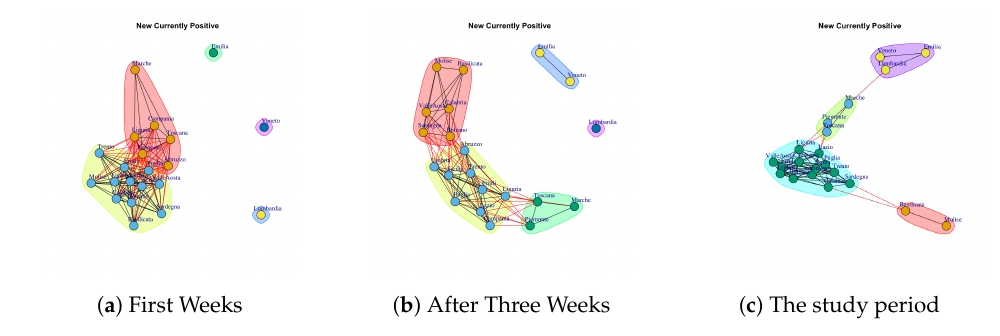
Figure 19. Evolution of New Currently Positive Network Communities.